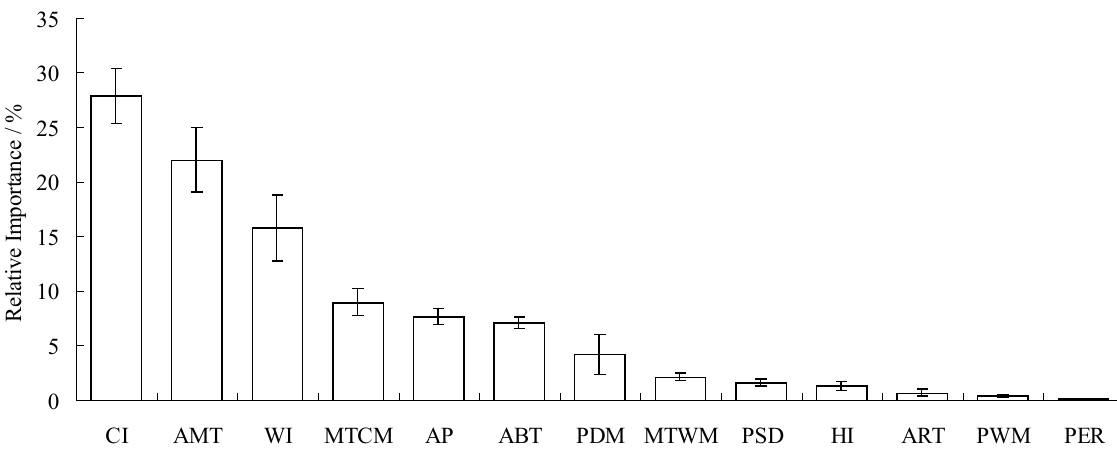
Figure 4. The relative importance of climatic factors (descending in order). The abbreviations CI, AMT, WI, WTCM, AP, ABT, PDM, MTWM, PSD, HI, ART, PWM and PET can be found in Table 1.